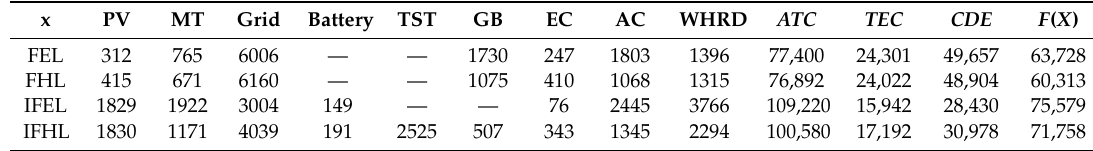
Table 5. Results of capacity optimization configuration.